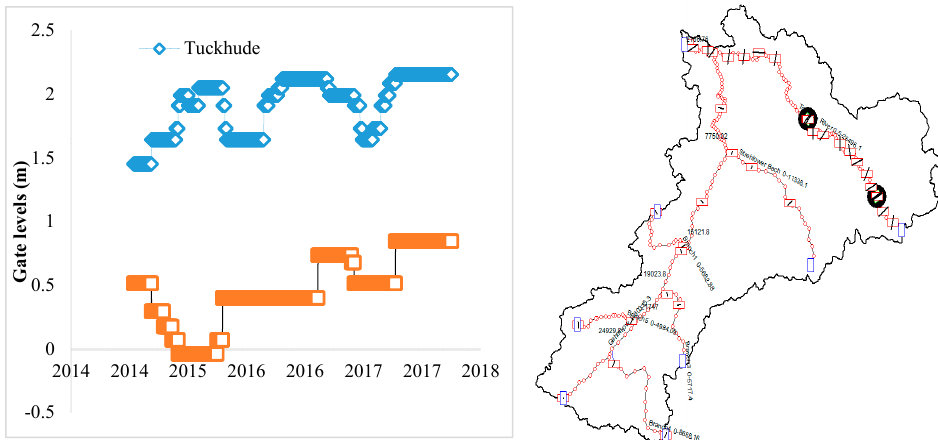
Figure 7. ( left ) Weir gate openings from reference level at Tückhude and Osten. ( right ) The MIKE 11 model of Tollense river and its tributaries, channel cross sections (red rectangles), and control structures (black circles).